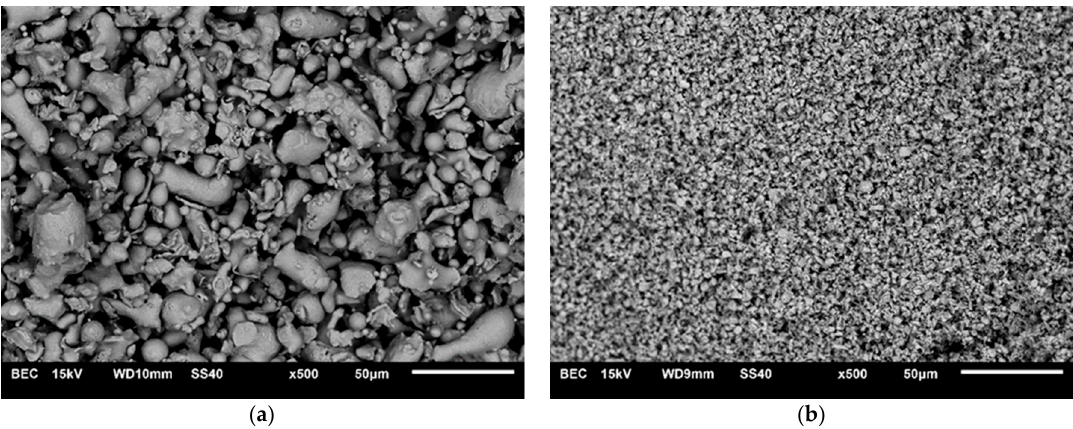
Figure 1. Scanning Electron Microscopy (SEM) images of ( a ) 316L steel and ( b ) zirconium boride (ZrB 2 ) powders.